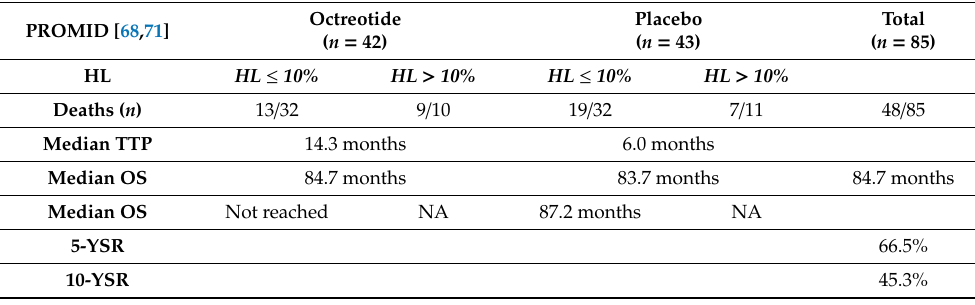
Table 1. Long-term results from the PROMID trial.